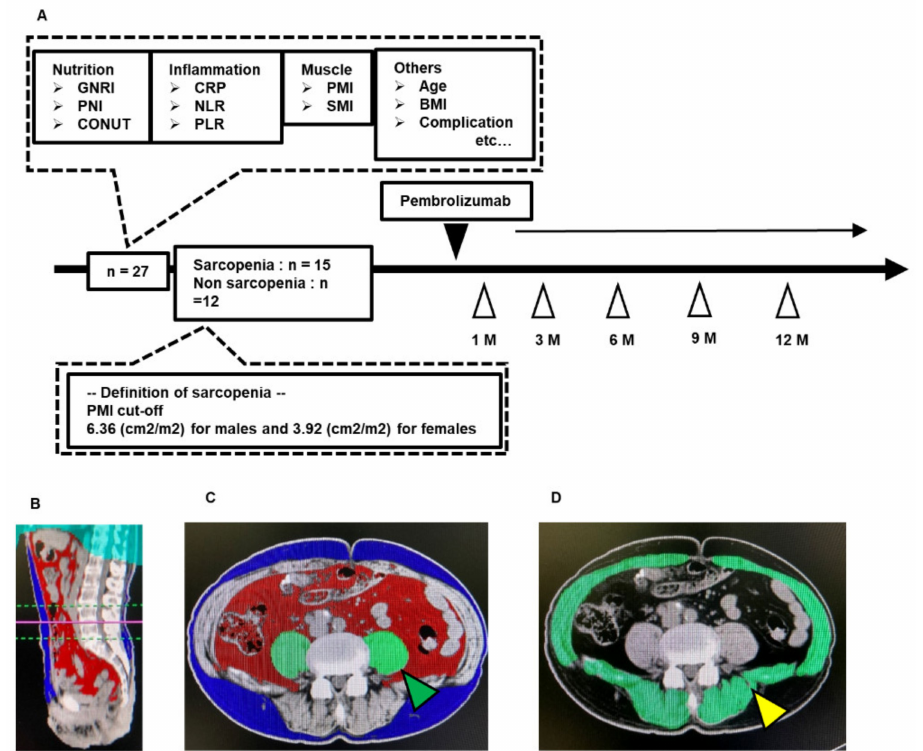
Figure 1. Schematic representation of study workflow ( A ) and representative images used for analyses of muscle mass-based markers ( B – D ). This study included 27 patients with mUC who received pembrolizumab at our institute between December 2017 and August 2019. Information regarding the pretreatment conditions was obtained retrospectively by reviewing the medical records, laboratory blood tests, and CT imaging. The PMI cut-o ff values of Hamaguchi et al. [20] were used to classify 15 patients as having sarcopenia and 12 patients as not having sarcopenia. Various biomarkers were evaluated before and during the administration of pembrolizumab. The Volume Analyzer SYNAPSE VINCENT image analysis system was used to reconstruct three-dimensional (3D) images as follows: sagittal plane of the psoas muscle area at the caudal end of the L3 level ( B ); coronal plane for assessment of the abdominal subcutaneous adipose tissue area (blue area), abdominal visceral adipose tissue area (red area), and psoas muscle area (green area indicated by green arrow) ( C ), and the skeletal muscle area (green area indicated by the yellow arrow) ( D ). UC, urothelial carcinoma; CT, computed tomography; GNRI, geriatric nutritional risk index; PNI, prognostic nutritional index; CONUT score, controlling nutritional status score; CRP, C-reactive protein; NLR, neutrophil-to-lymphocyte ratio; PLR, platelet-lymphocyte ratio; SMI, skeletal muscle mass index; PMI, psoas muscle mass